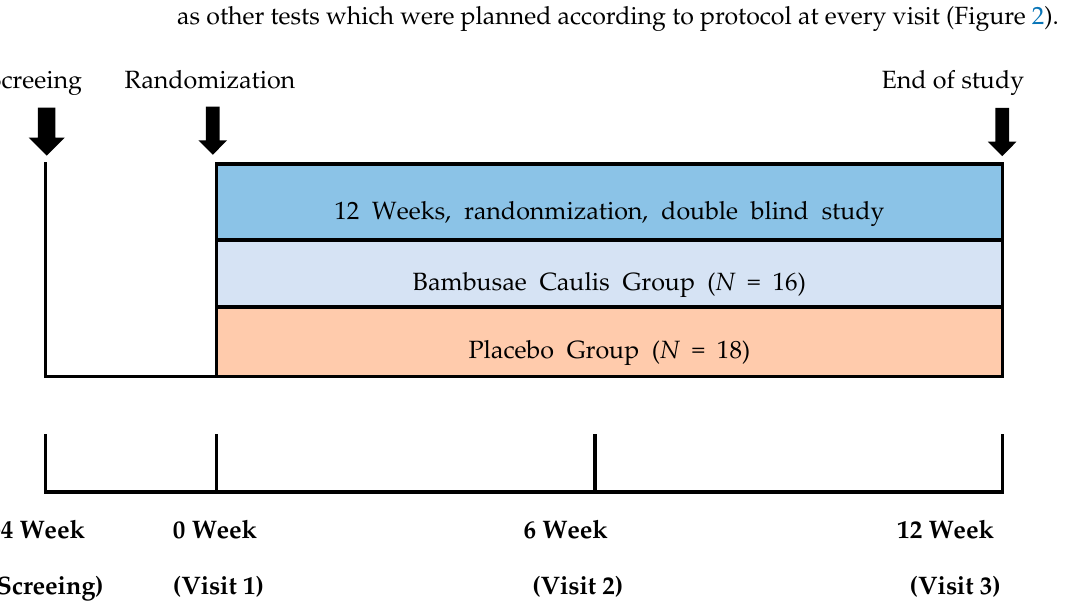
Figure 2. Subject visit flow. A total of 12 weeks, randomization, double blinded, placebo study Bambusae Caulis group ( n = 16) and Placebo group ( n = 18).